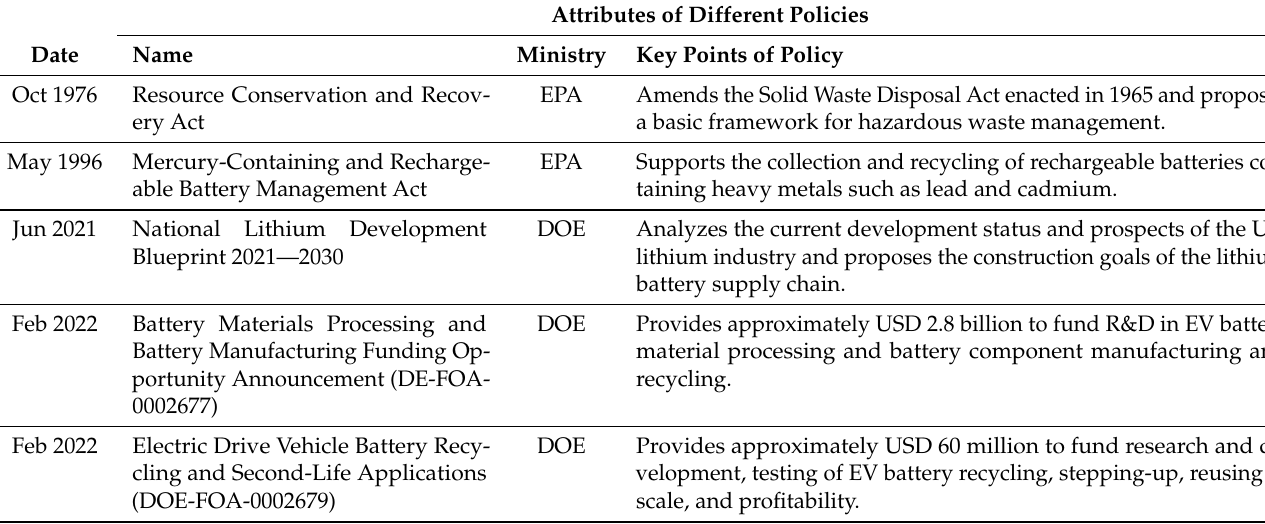
Table 2. Federal regulations on EoL power battery recycling in the